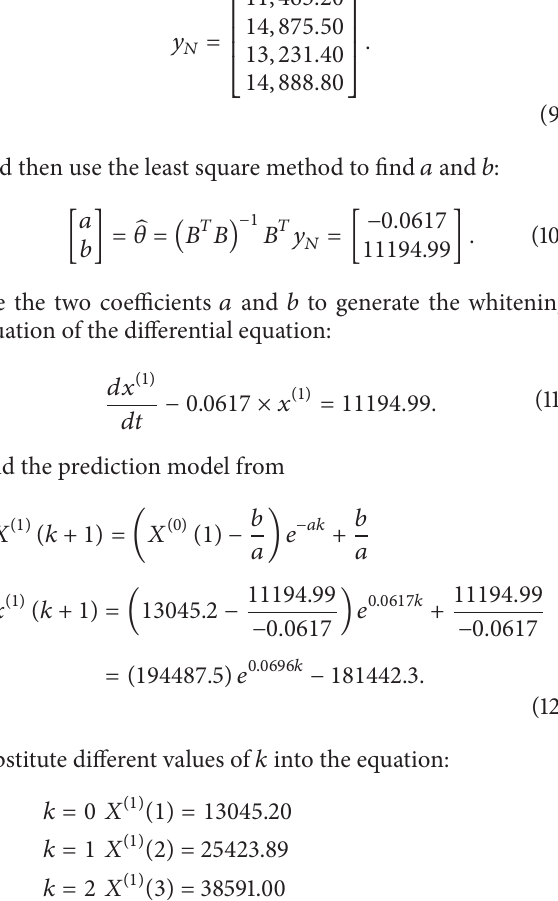
Table 4: Average MAPE of DMUs.